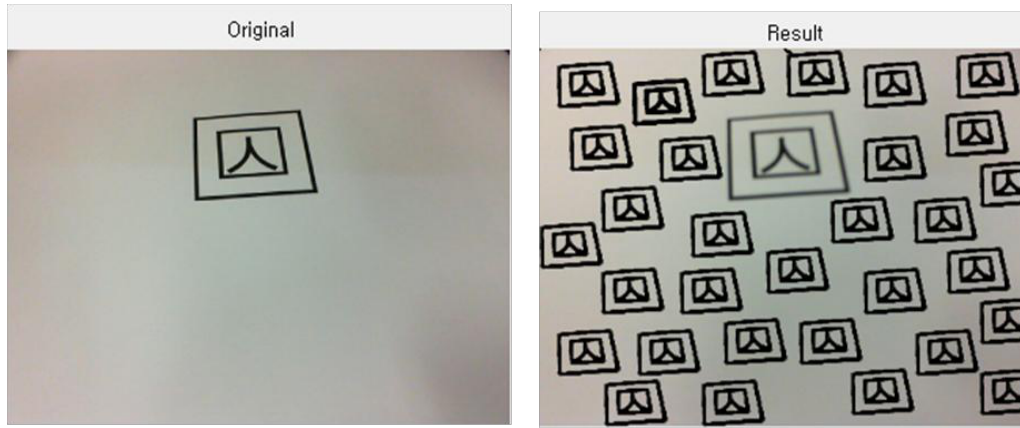
Figure 11. Multiple objects loading after removing